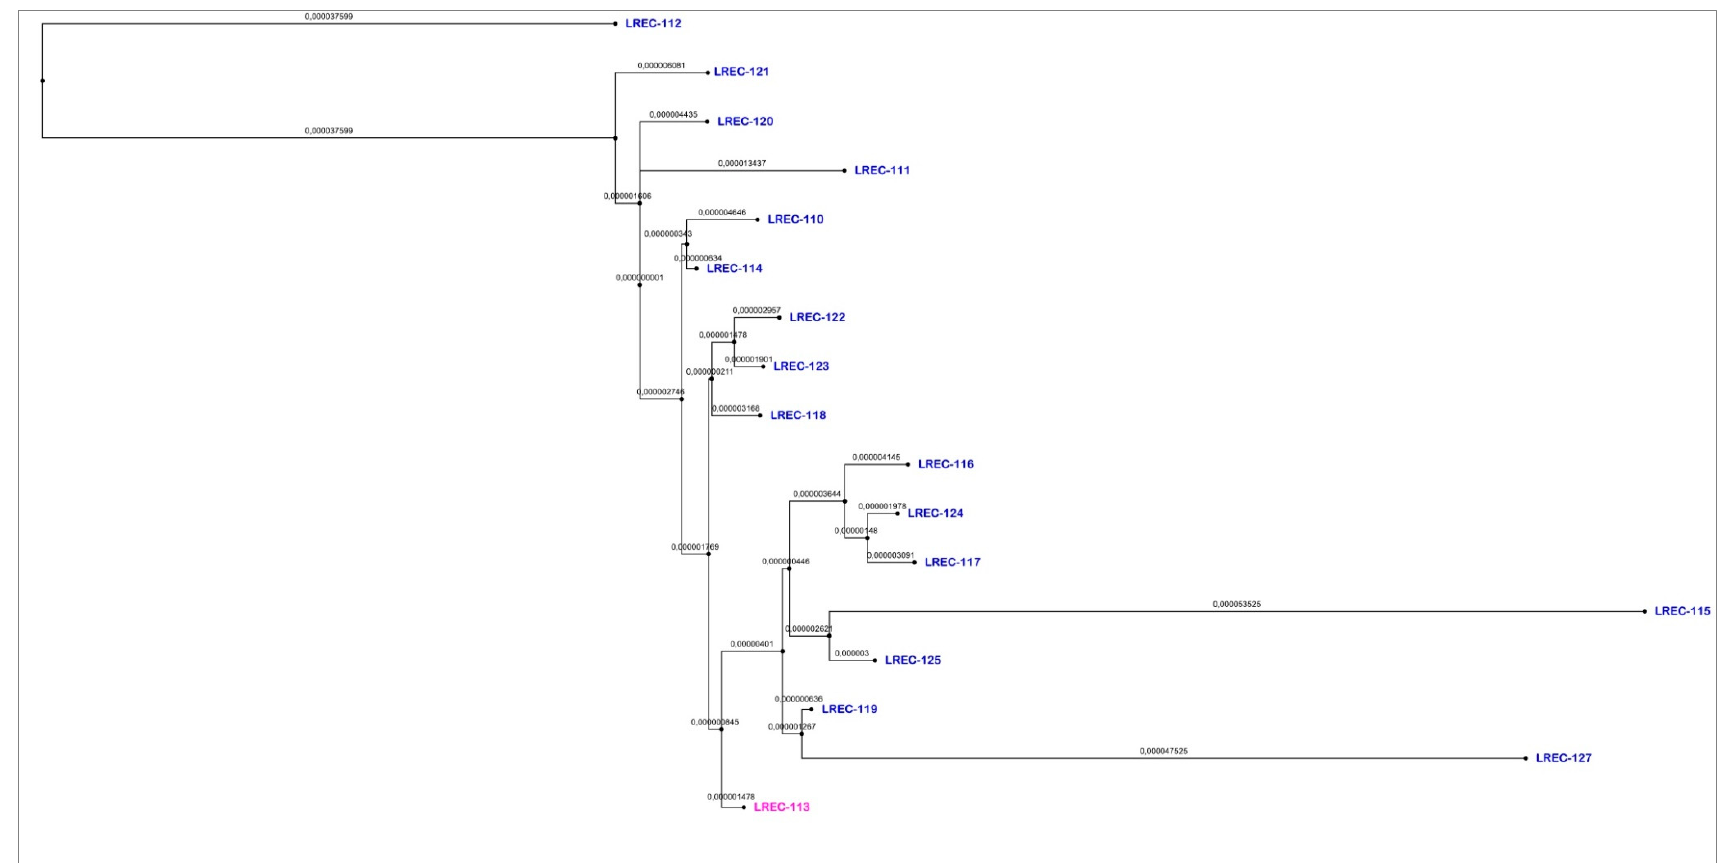
Figure 3. Dendrogram based on the SNPs of the core genomic regions present in 90% of the compared genomes and using LREC-113 as reference, built in EnteroBase and modified with FigTree v1.4.3.